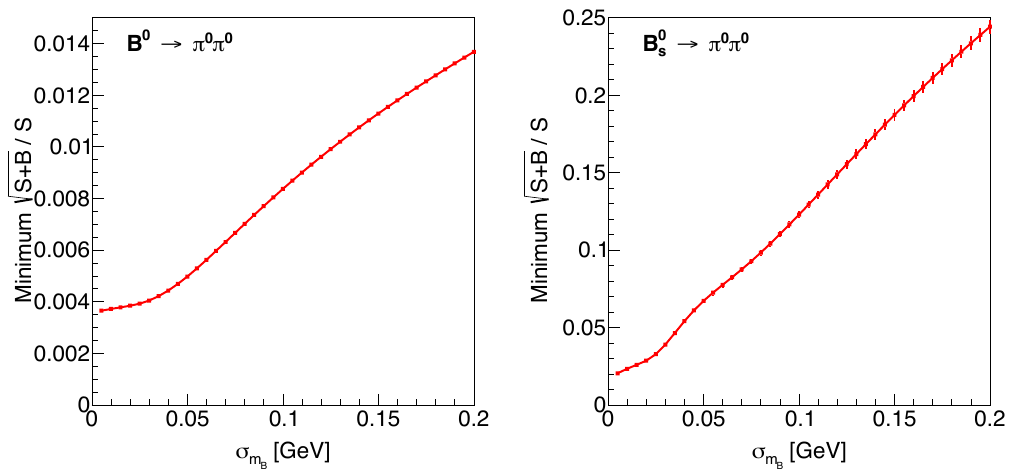
Figure 24 . Measurement precision of B 0 → π 0 π 0 (left) and B 0 mass resolution σ m B